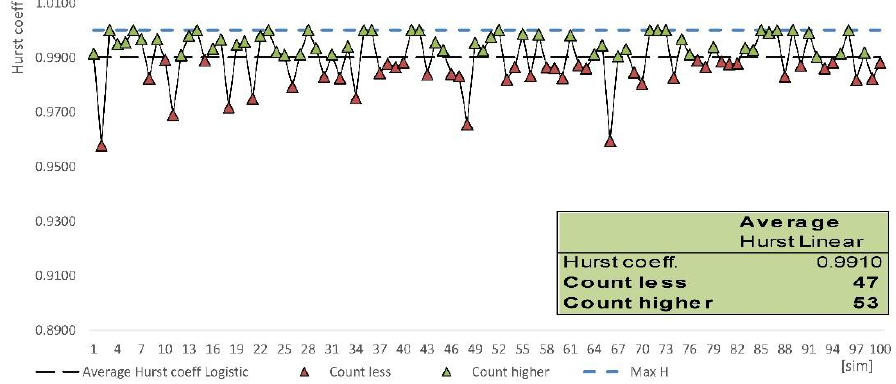
Figure 7. Value under- and above-average of Hurst coefficient (linear variant). (Source: authors).